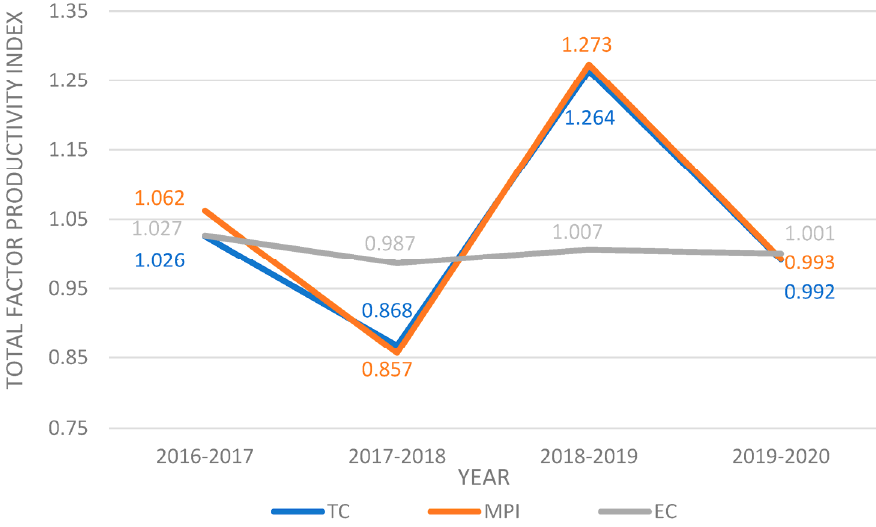
Figure 8. Changes in the total factor productivity index of the Yangtze River Delta coastal port group.